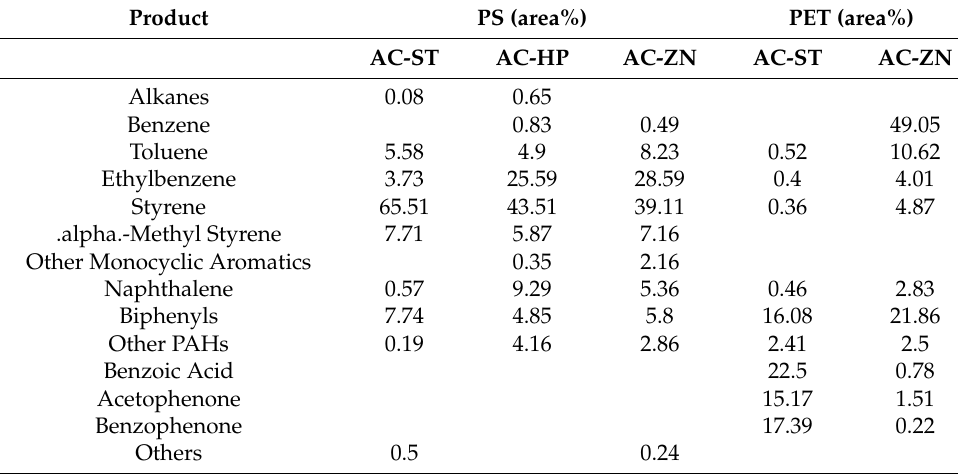
Table 4. The composition of liquid obtained by the cracking of PS and PET.